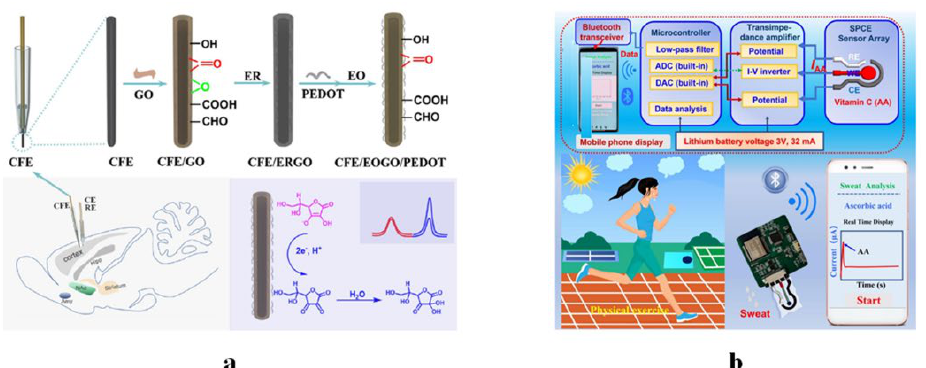
Figure 8. ( a ) Schematic illustration of the designed electrochemical platform for the ratiometric measurement of AA in a living mouse brain. Reprinted with permission from Ref. [66]. Copyright 2021, the American Chemical Society. ( b ) Block diagram of part of the circuitry in the portable enzyme-free AA detection system and the illustration showing the concept of non-invasive human health monitoring using this system with an integrated ASIC, Ni 3 (HITP) 2 /SPCE sensing electrode, and smartphone with App. Reprinted with permission from Ref. [162]. Copyright 2022,